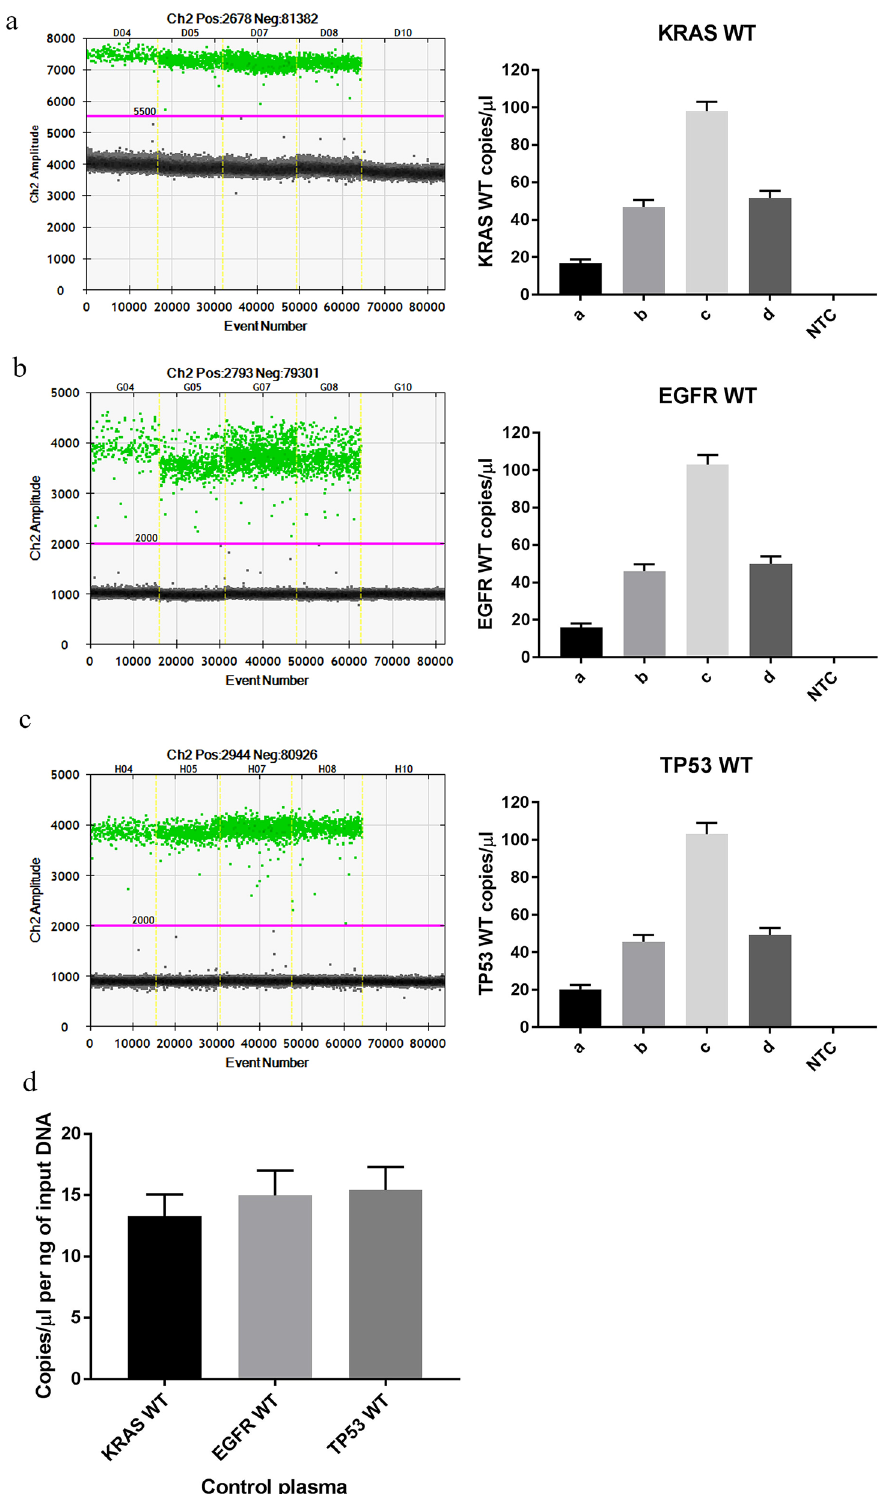
Figure 4. ddPCR analysis of DNA extracted from Vn96-isolated EVs from control patient plasma (n = 4). ( a ) KRAS WT ddPCR amplitude vs event number graph (left) and resulting KRAS WT copies ± Poisson confidence min and max for each control patient. Images were generated from BioRad QuantaSoft software (v1.7.4, https:// www. bio- rad. com/ en- ca/ sku/ 18640 11- quant asoft- softw are- regul atory- editi on? ID= 18640 11, accessed on 28/01/2021). ( b ) EGFR WT ddPCR amplitude vs event number graph (left) and resulting EGFR WT copies ± Poisson confidence min and max for each control patient. ( c ) TP53 WT ddPCR amplitude vs event number graph (left) and resulting TP53 WT copies ± Poisson confidence min and max for each control patient. ( d ) Average normalized to DNA input copies ± SEM for KRAS WT, EGFR WT and TP53 WT (n =